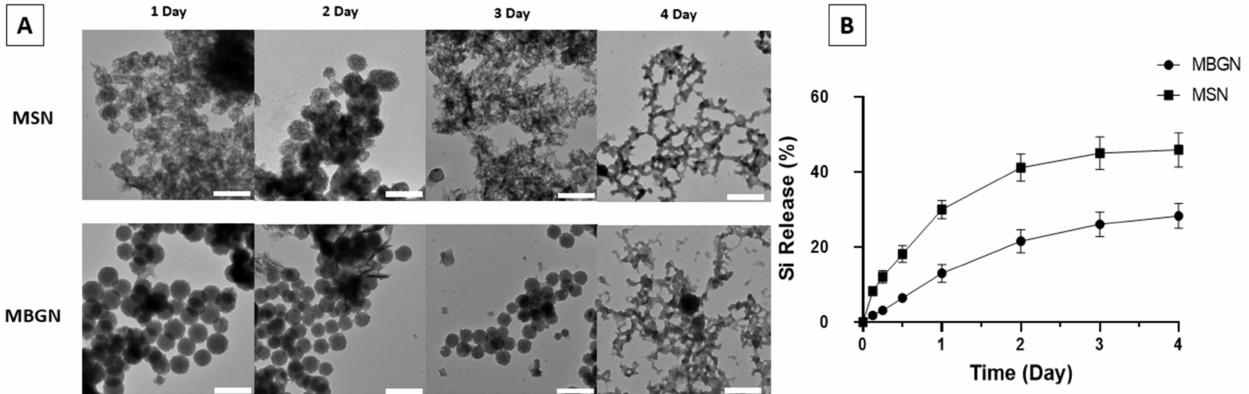
Figure 2. TEM images displaying the morphological changes of MSN-PEI and MBGN-PEI in PBS at pH 7 after 1, 2, 3 and 4 days ( A ) (scale bar 200 nm). The percentage of Si release was evaluated by ICP-OES ( B